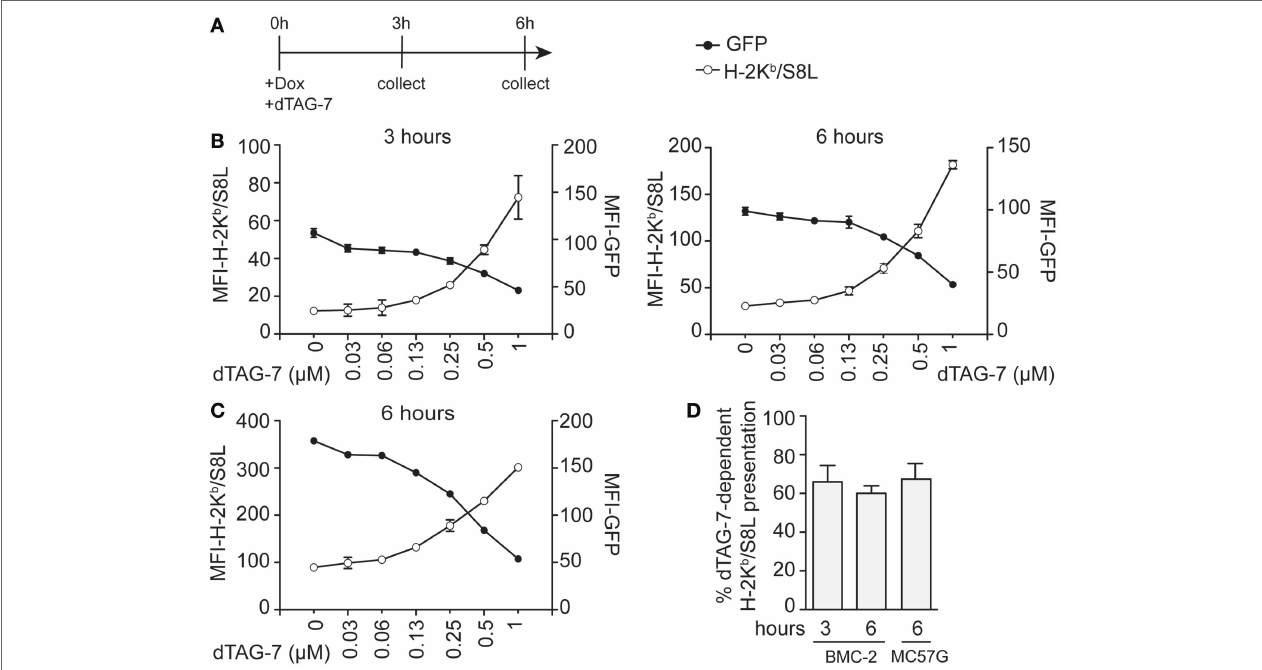
FigUre 4 | Minor contribution of defective ribosomal products to the direct MHC class I presentation of GFP-S8L-F12-derived S8L. (a) Timeline of the experiments performed in (B,c) . (B,c) BMC-2 cells (B) or MC57G cells (c) were simultaneously treated with 1 µg/mL doxycycline (Dox) and 1 µM degradation tag (dTAG)-7 to induce GFP-S8L-F12 expression and degradation at the same time. Next, GFP-specific fluorescence (MFI-GFP) and MHC class I presentation of GFP-S8L-F12- derived S8L (MFI-H-2K b /S8L) was detected by flow cytometry after 3 and 6 h, as indicated. MFI, mean fluorescence intensity. (D) Quantification of three independent experiments performed in (B,c) (for calculation details see Materials and Methods). All experiments were performed in triplicates and results are shown as mean ± SEM. (B,c) Representative results from three independent experiments are